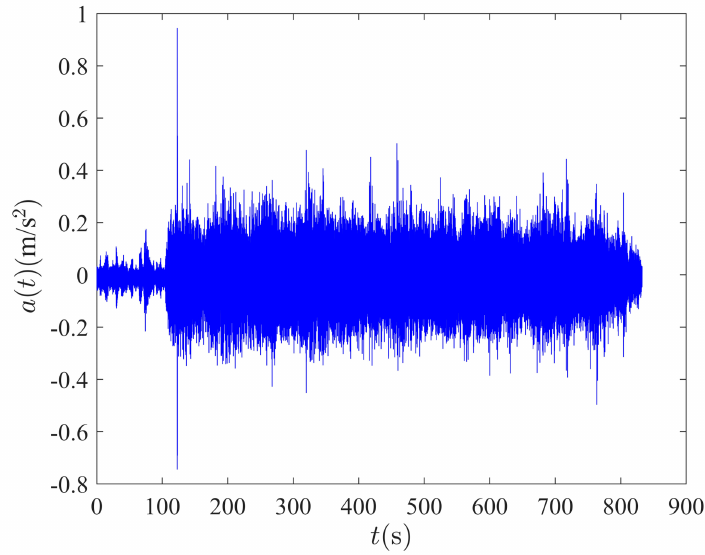
Figure 5. Time-domain signal of Eeklo Pedestrian Bridge for test